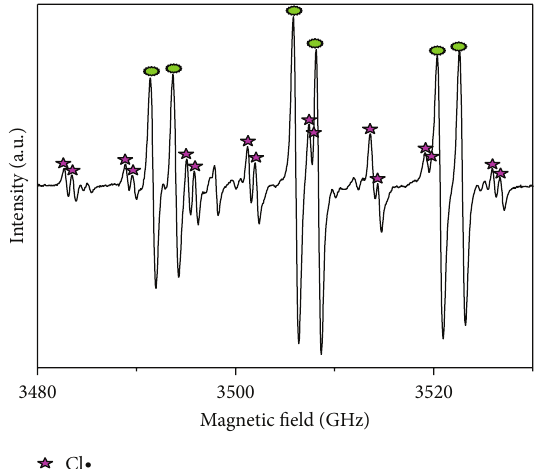
Figure 1: EPR spectrum as the evidence for chlorine radicals and phenyl radicals using PBN as trapping